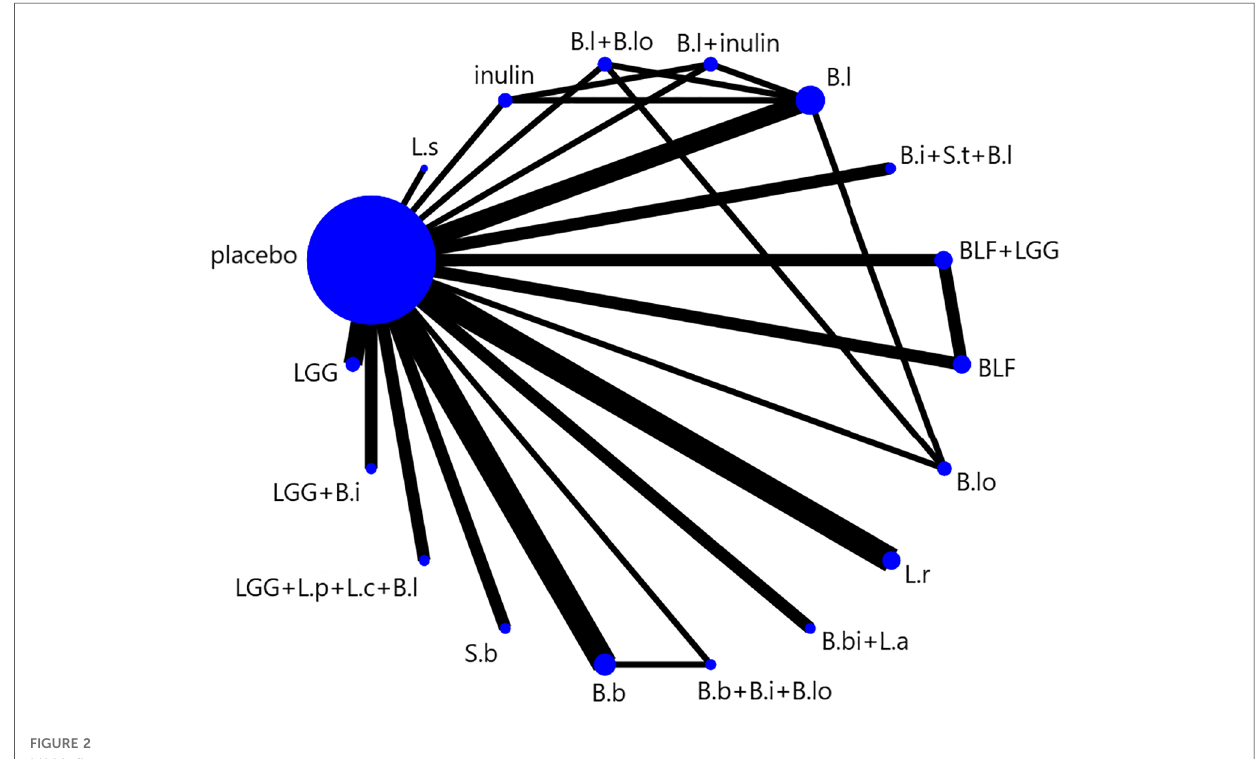
FIGURE 2 NMA fi gure.